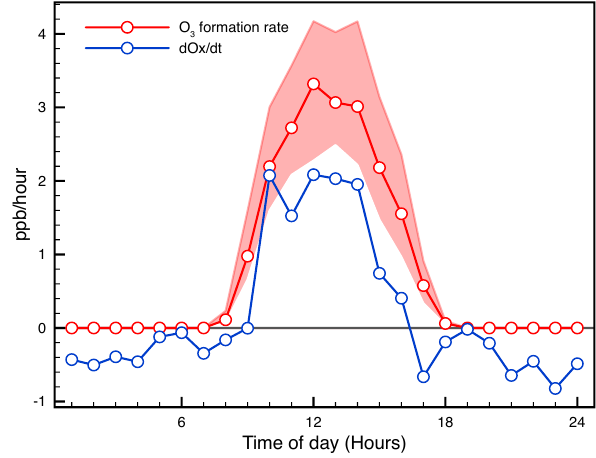
Figure 7. Calculated daytime O 3 formation rate and the rate of change of O x (NO 2 + O 3 ) observed. The difference between traces can be attributed to mixing using the same mixing rate estimated from n -propyl nitrate. The existence of non-negligible background O 3 concentration (30ppb) suppresses the net